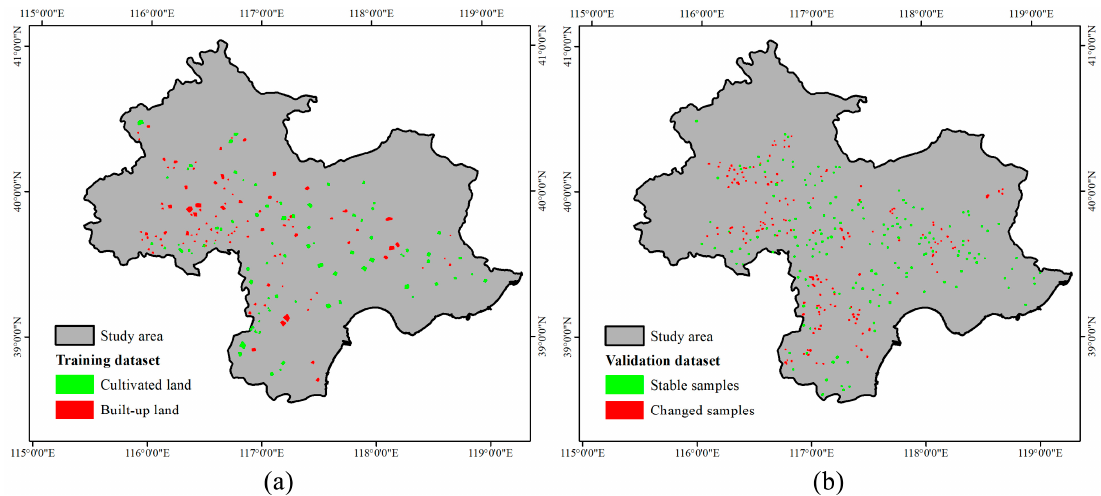
Figure 6. The spatial distribution of the training and validation samples. (a) Training dataset; (b) validation dataset. (The digitalized polygons are buffered 500 meters to show more clearly).